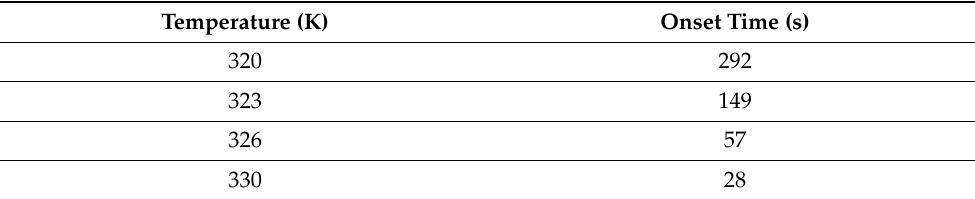
Table 4. Measurement data of the a-SiN x :H thin film sputtered at a H 2 flow of 6 sccm (S4) for the Arrhenius plot.